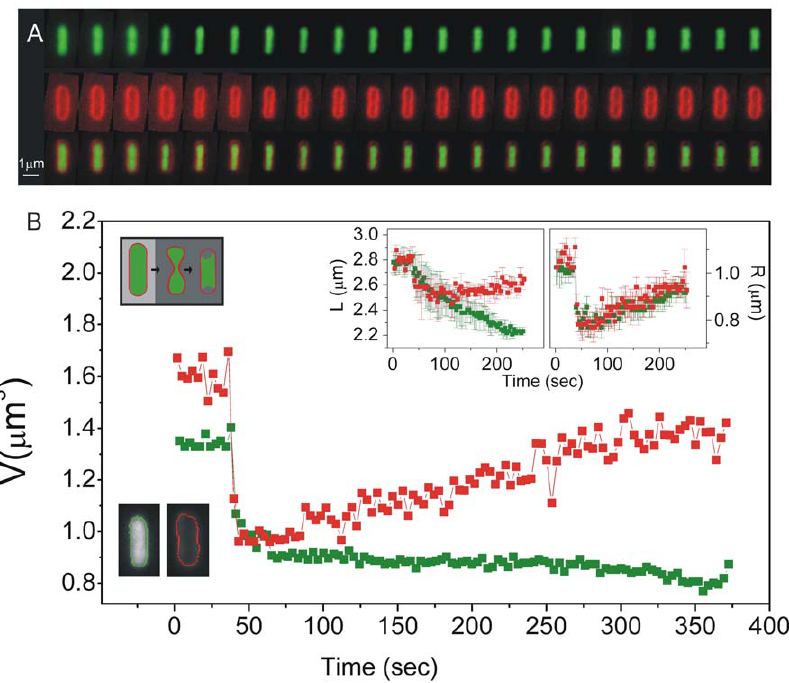
Figure 1. Passive response to hyperosmotic shock involves two phases of cell shrinking. (A) A sequence of fluorescent images of E.coli cells prior and during the hyperosmotic shock. Top: cytoplasmic volume marked with the green protein EGFP; Middle: total cell volume marked by the red outer membrane dye FM4-64; Bottom: overlay if EGFP and FM4-64. A cell is transferred from isoosmotic buffer (10 mM Tris-HCl buffer supplemented with 150 mM sucrose) to isoosmotic buffer and 620 mM sucrose. Images were acquired at a frame every 1.6 seconds alternating between the cytoplasmic volume and total cell volume. Image brightness was adjusted due to photo bleaching and the difference in fluorescence intensity between the FM4-64 and EGFP. Videos are given in Video S1 and S2. (B) Volume recovery versus time obtained using cell area analysis. Inset: cell length and cell radius versus time. Total cell volume, length and radius are given in red and cytoplasmic cell volume, length and radius in green. An example contour of the cytoplasmic cell volume and total cell volume obtained after cell area analysis for the initial frame is shown on the bottom left. The inset shows a cartoon illustration of the post sucrose shock events described in the text.